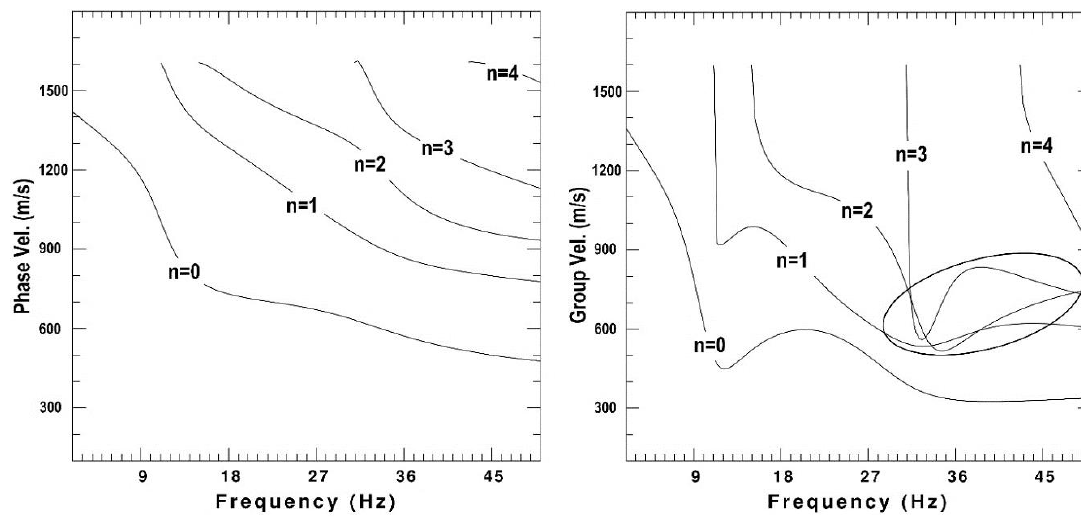
Figure 4. Phase (left panel) and group (right panel) velocity dispersion curves for the model structure in Table 2 are shown. The fundamental mode – FM is labeled n=0 and then higher modes are labeled with increasing numbers, i.e., n=1, n=2, n=3, and so on. The phase and group velocities are shown in the range 300-1700 m/s.